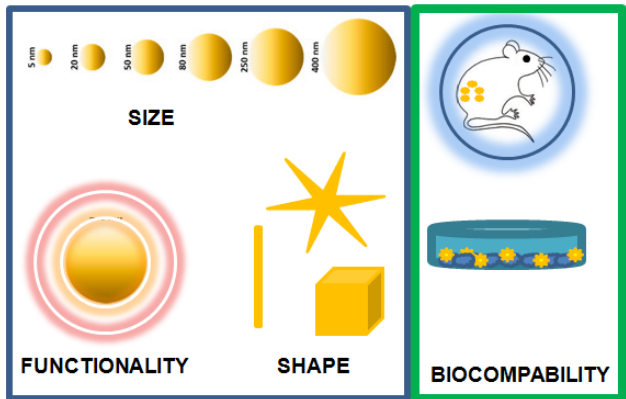
Figure 7. Key properties of engineered gold-based nanomaterials in biomedical applications.